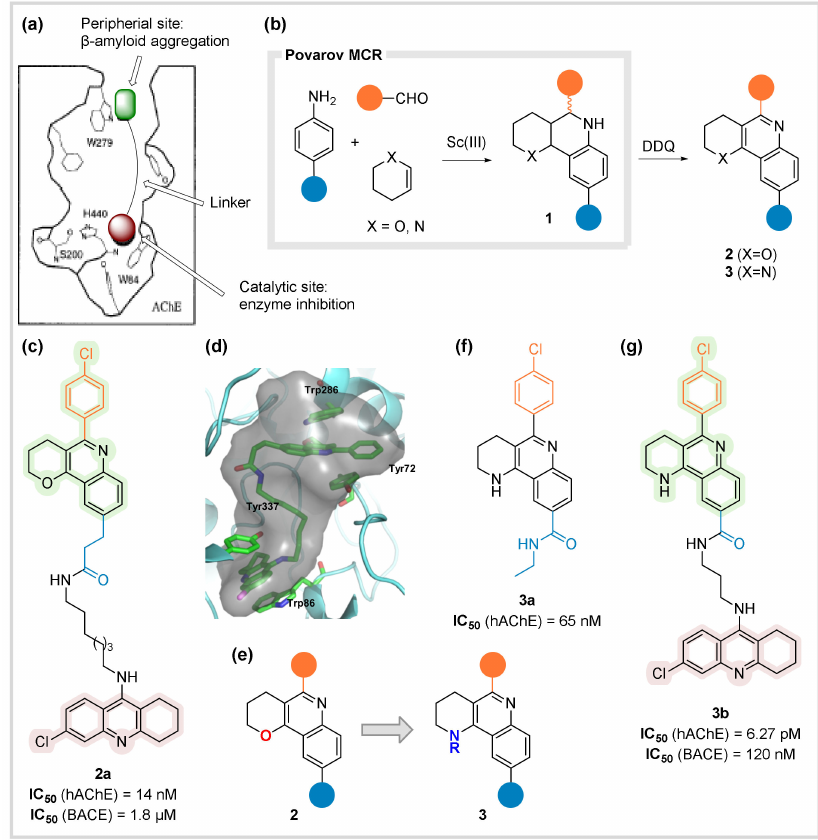
Figure 2. AChE inhibitors. ( a ) Outline of the AChE dual inhibition. ( b ) The Povarov MCR and subsequent oxidation leading to the new peripheral site inhibitors. ( c ) Structure and pharmacological data for the dual AChE inhibitor 2a . ( d ) Docking simulation showing the interactions at the catalytic and peripheral sites. From ref. [28] (P. Camps et al., J. Med. Chem . 2009 , 52 , 5365), reproduced with permission. Copyright 2009 ACS. ( e ) Isosteric modification in the peripheral site inhibitor core. ( f ) Structure and pharmacological data of small molecule peripheral site inhibitor 3a . ( g ) Structure and pharmacological data for the dual AChE inhibitor 3b